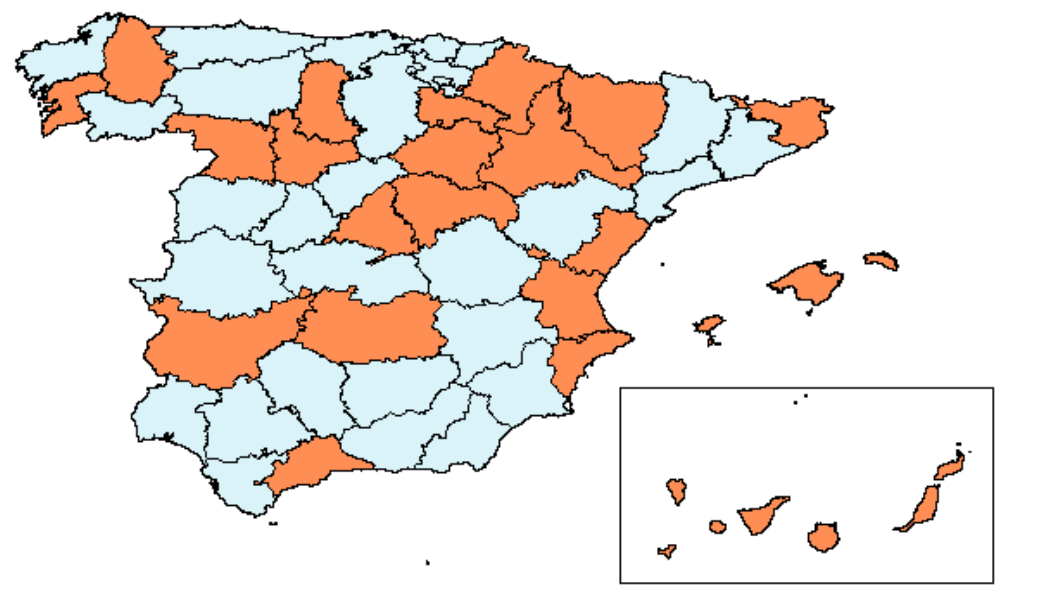
Figure 7. Spatial distribution of the regions with a negative and significant second structural break.